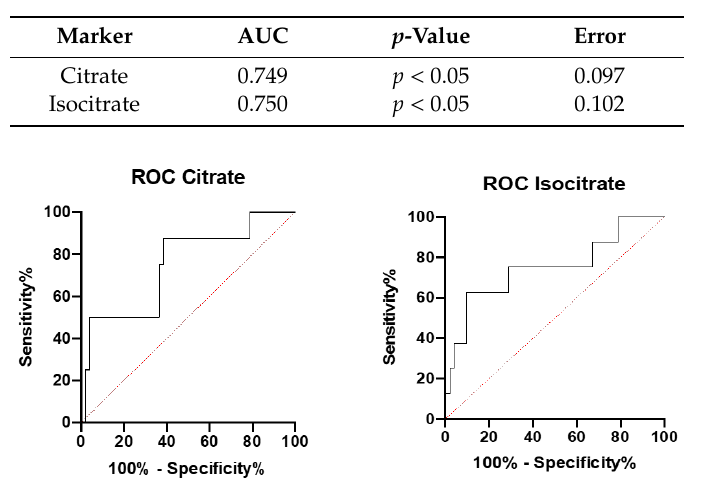
Figure 2. A receiver operating characteristic curve (ROC) for citrate and isocitrate by Prism 8 (GraphPad). NAFLD ( n = 22) and controls ( n = 67). Table 3. Evaluation of isocitrate and citrate as mitochondrial dysfunction markers in NAFLD. AUC— area under the curve.